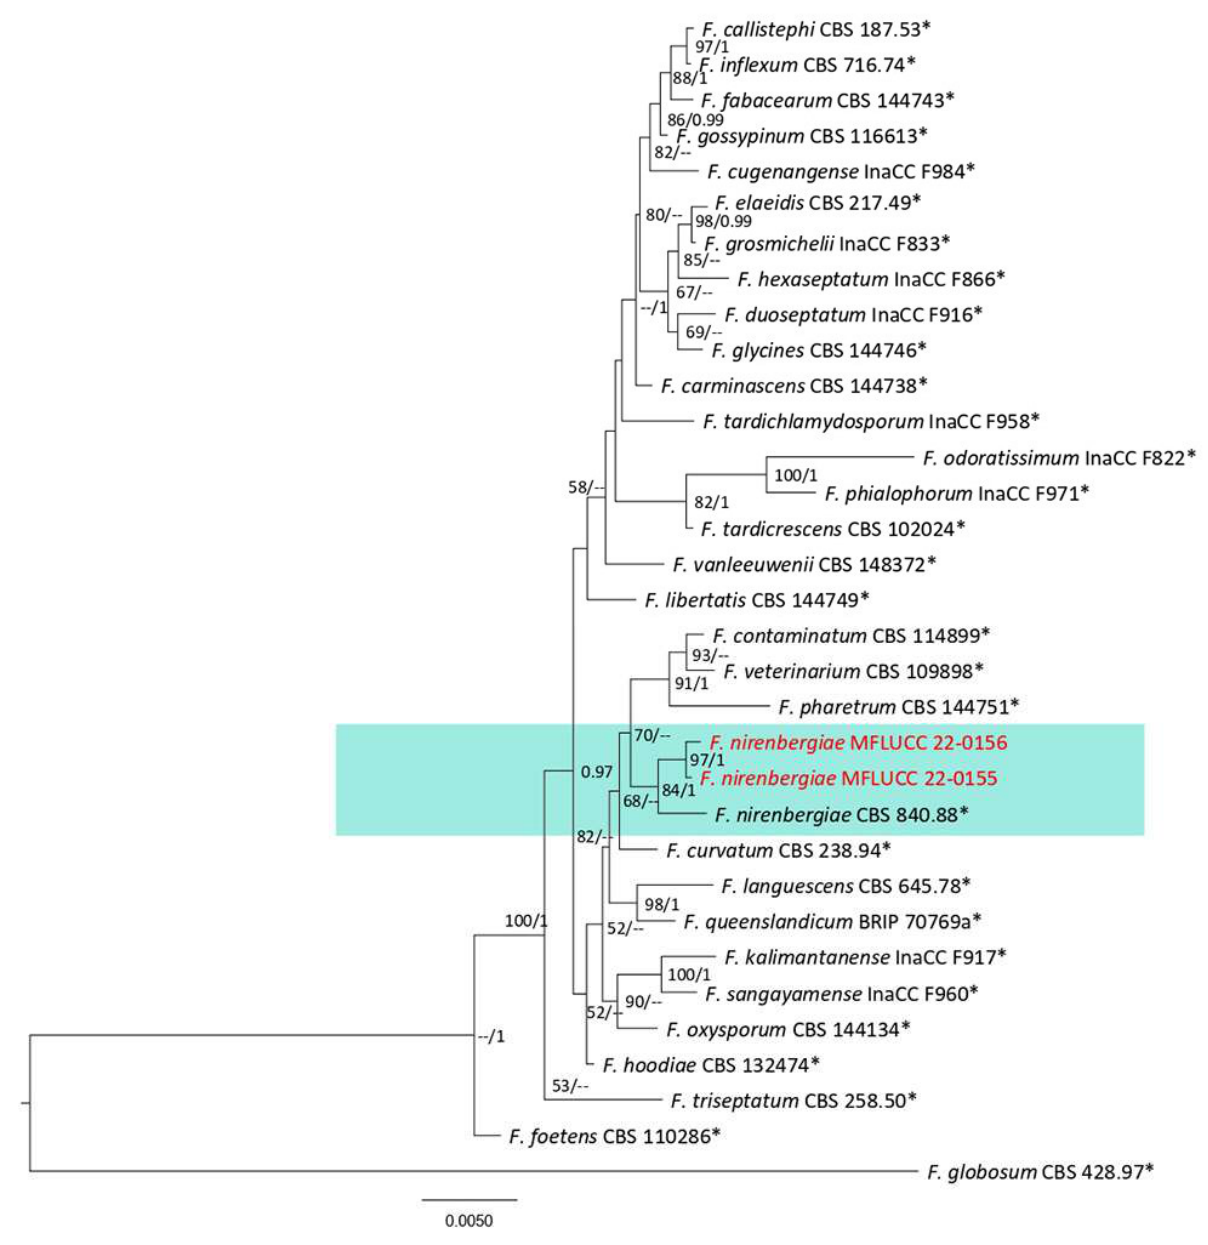
Figure 37. Fusarium oxysporum complex. Bayesian phylogenetic tree obtained from the combined of the tef1 , rpb1 , and rpb2 sequence data. The ultrafast maximum likelihood bootstrap support (%) ≥ 50 and BYPP ≥ 0.95 are shown at the nodes. The ex-type strains are marked with an asterisk. The tree was rooted with F. globosum (CBS 428.97).